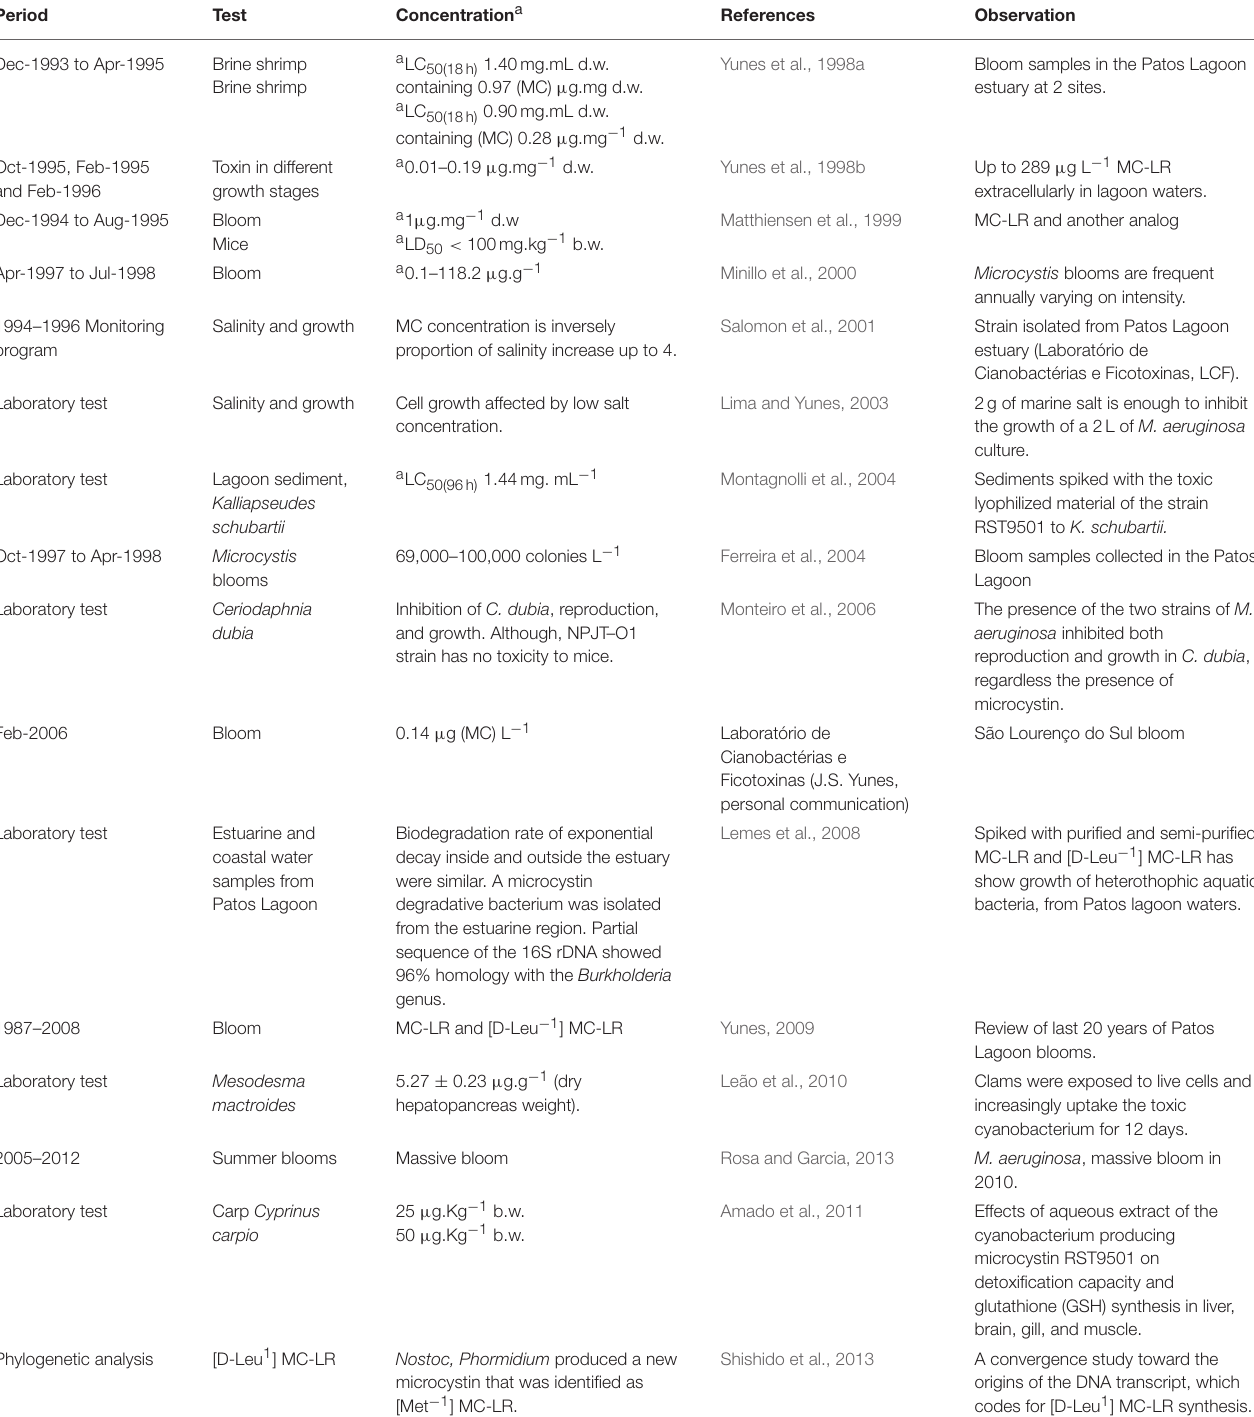
TABLE 2 | Studies with Microcystis aeruginosa blooms and strain RST9501 isolated from the Patos Lagoon estuary from 1994 to 2012.